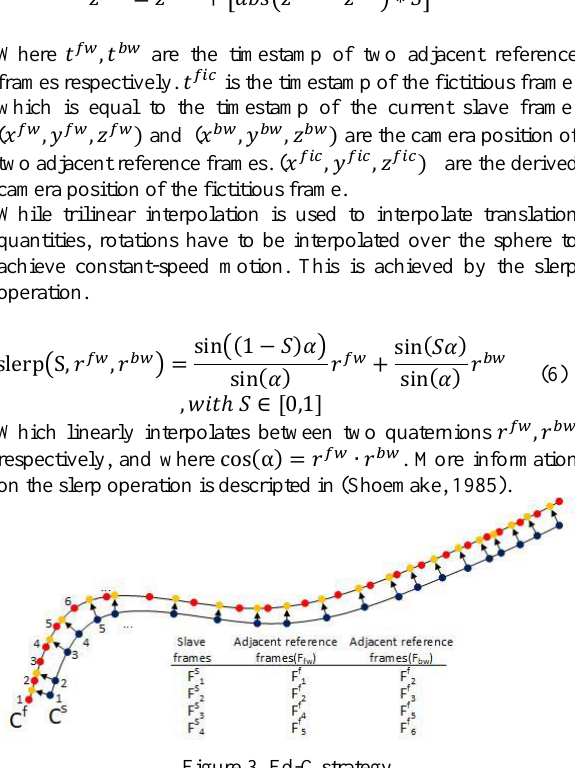
Figure 3. Fd-C strategy